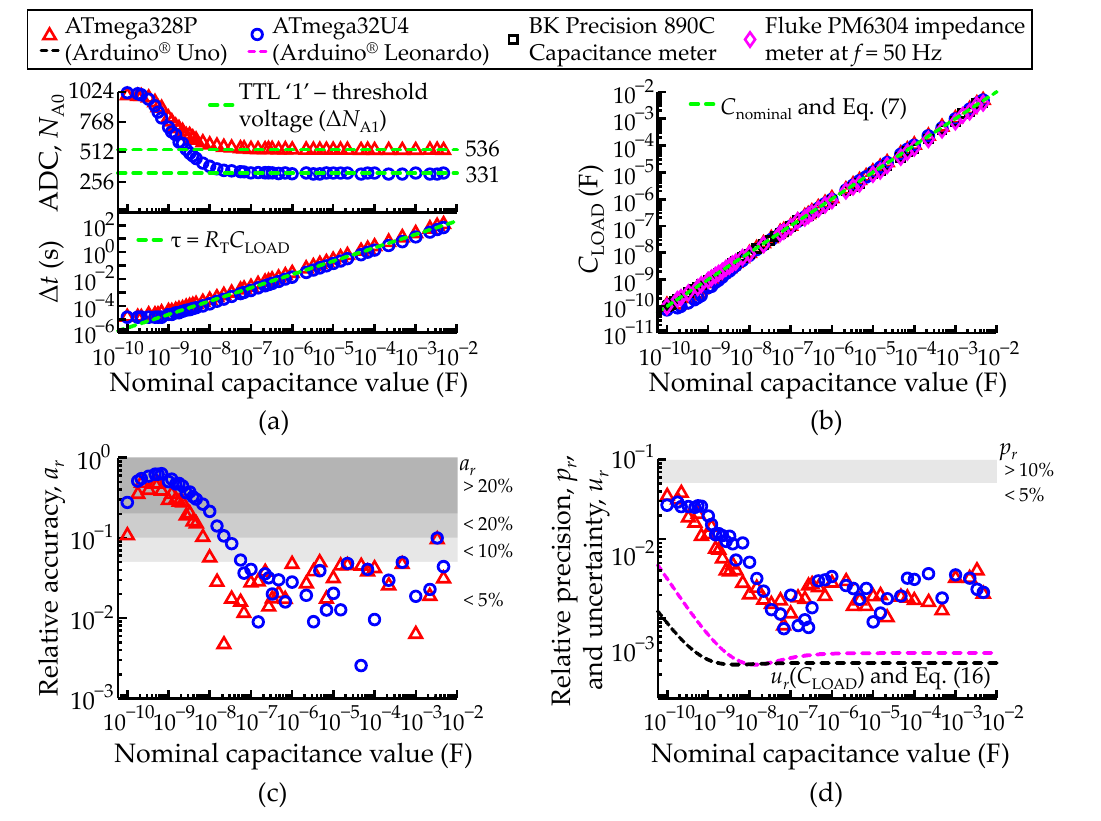
Figure 10. Comparison between the ATmega328P and ATmega32U4 AVR ® micro-controllers con- figured to record an isolated load capacitance ( C LOAD ) through the transient acquisition mode. ( a ) Measured ADC value and time ( Δ t ) until the TTL unit changes to digital state high, logic ‘1’ at port P A0 ( N A0 ). Each ADC and Δ t sample consist of an average of 100 consecutive measurements. ( b ) Measured load capacitance ( C LOAD ) given by Equation (7). The green dashed lines represent the the- oretical lines. ( c ) Relative accuracy ( a r ) and ( d ) relative precision ( p r ) of the measurements in function of C nominal . The black dashed line represents the relative uncertainty ( u r ) of the C LOAD measurements according to Equation (16). The white and grey shading areas highlight the levels of u r , a r and p r better than 5%, 10% and 20%. A legend to describe the color scheme used in all plots of Figure 10 was included.